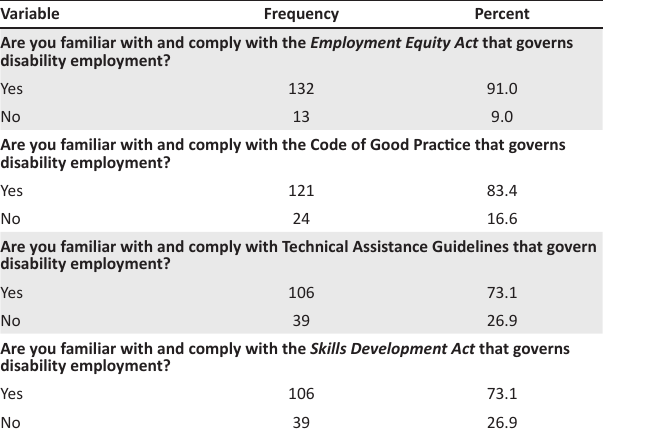
TABLE 7: Response to knowledge and compliance with acts and policies regulating disability employment. Variable